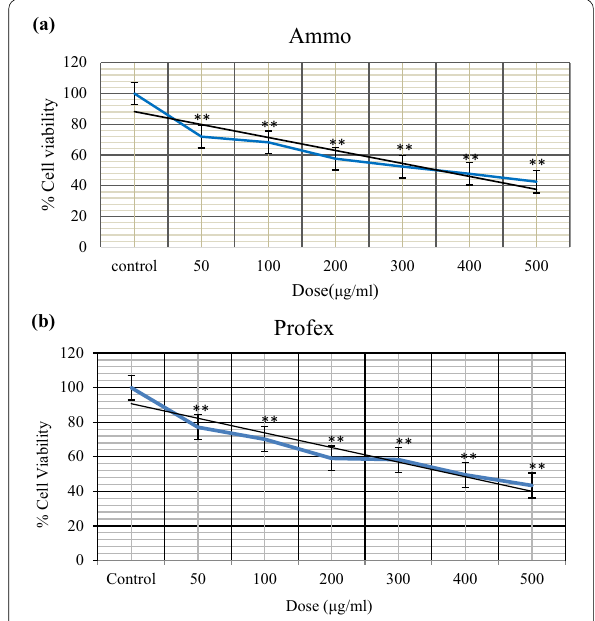
Fig. 1 Dose–response curve for the effect of Ammo and Profex on Sf9 cells. Viability of Sf9 cells subjected to varying concentration of Ammo ( a ) and Profex ( b ) treatment for 48 h was determined by MTT assay. Results are presented as Mean determined by One-way